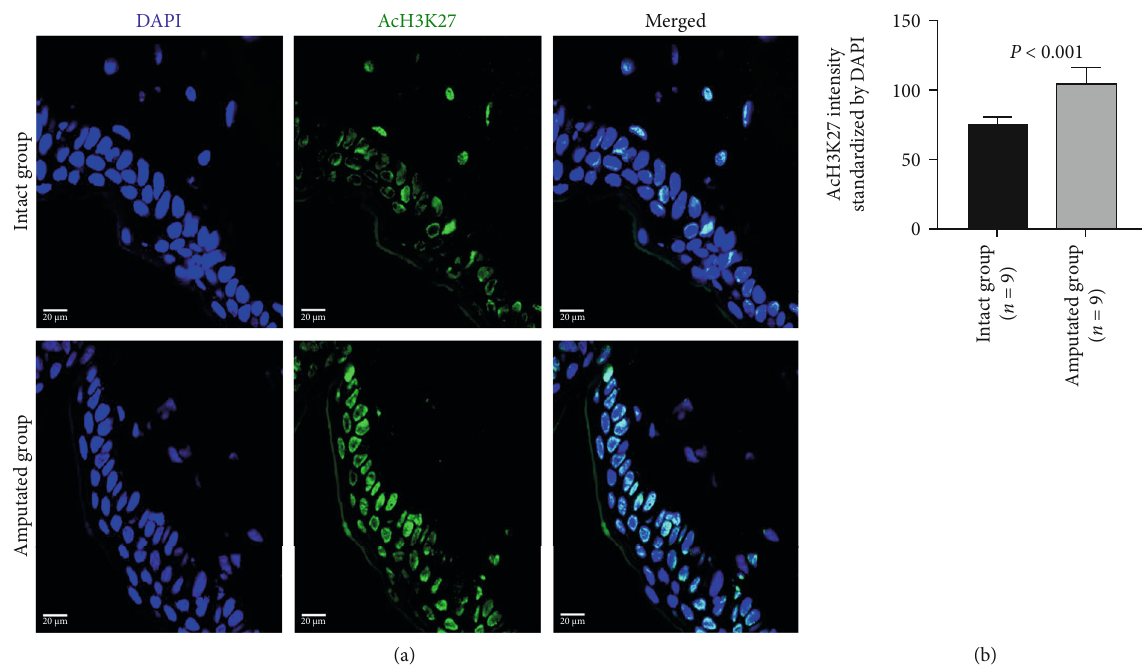
Figure 5: Immunohistochemical analysis on the acetylation of H3K27 in tissue cells 3 days after amputation. Representative images (a) and quantitative data (b) show the expression of acetylated H3K27 (AcH3K27) in intact tails and amputated tails. Quantitative data was normalized by DAPI. Scale bar: 20 μ m.